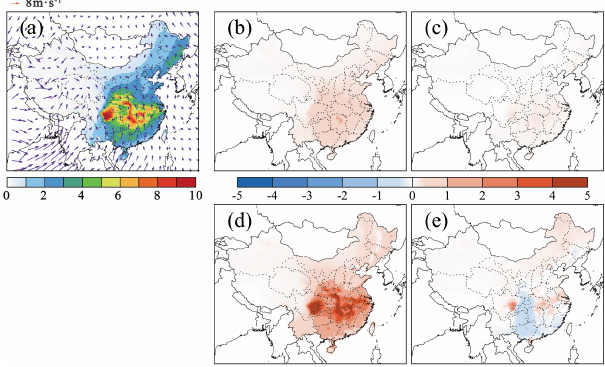
Figure 7. Spatial distributions of simulated SOA from biogenic sources in the different cases in summer. Unit is micrograms